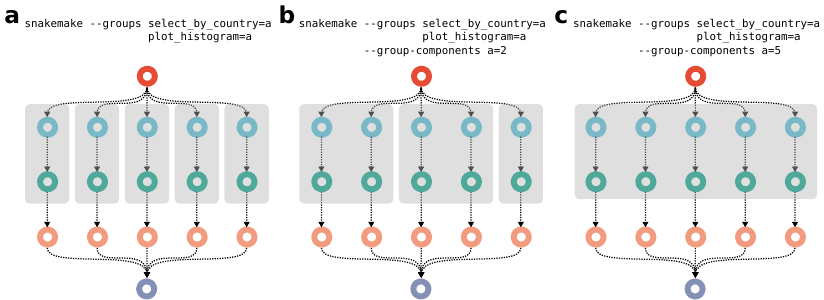
Figure 6. Job graph partitioning by assigning rules to groups. Two rules of the example workflow (Figure 3a) are grouped together, ( a ) spanning one connected component, ( b ) spanning two connected components, and ( c ) spanning five connected components. Resulting submitted group jobs are represented as grey